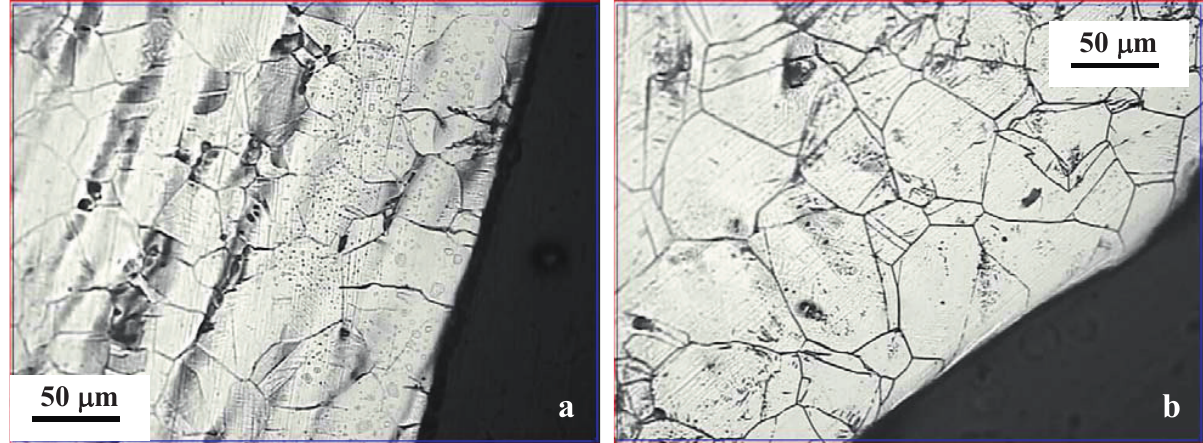
Figure 5. Optical micrographs of surface of fatigue tested 316L(N) base metal at 873 K, (a) in air and (b) in sodium .